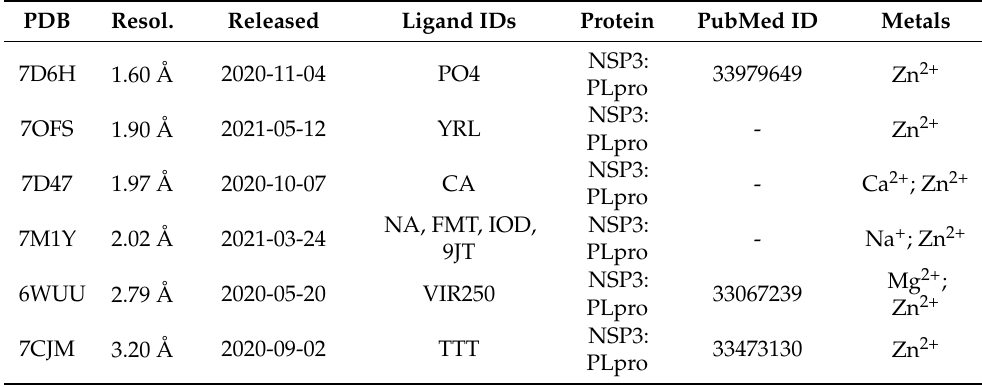
Table 2. SARS-CoV-2 PLpro